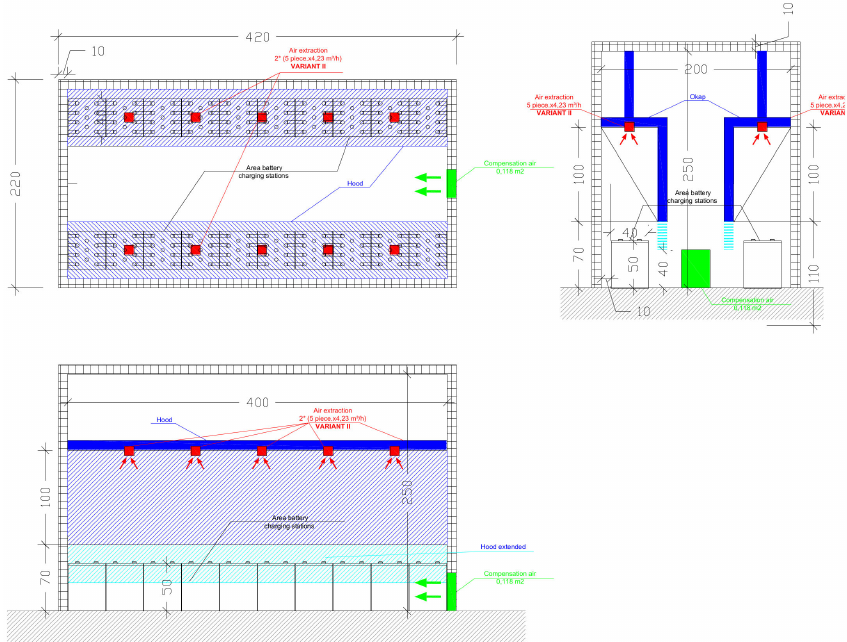
Figure 9. The mechanical ventilation system scheme with exhaust points in the hoods and supply point near the